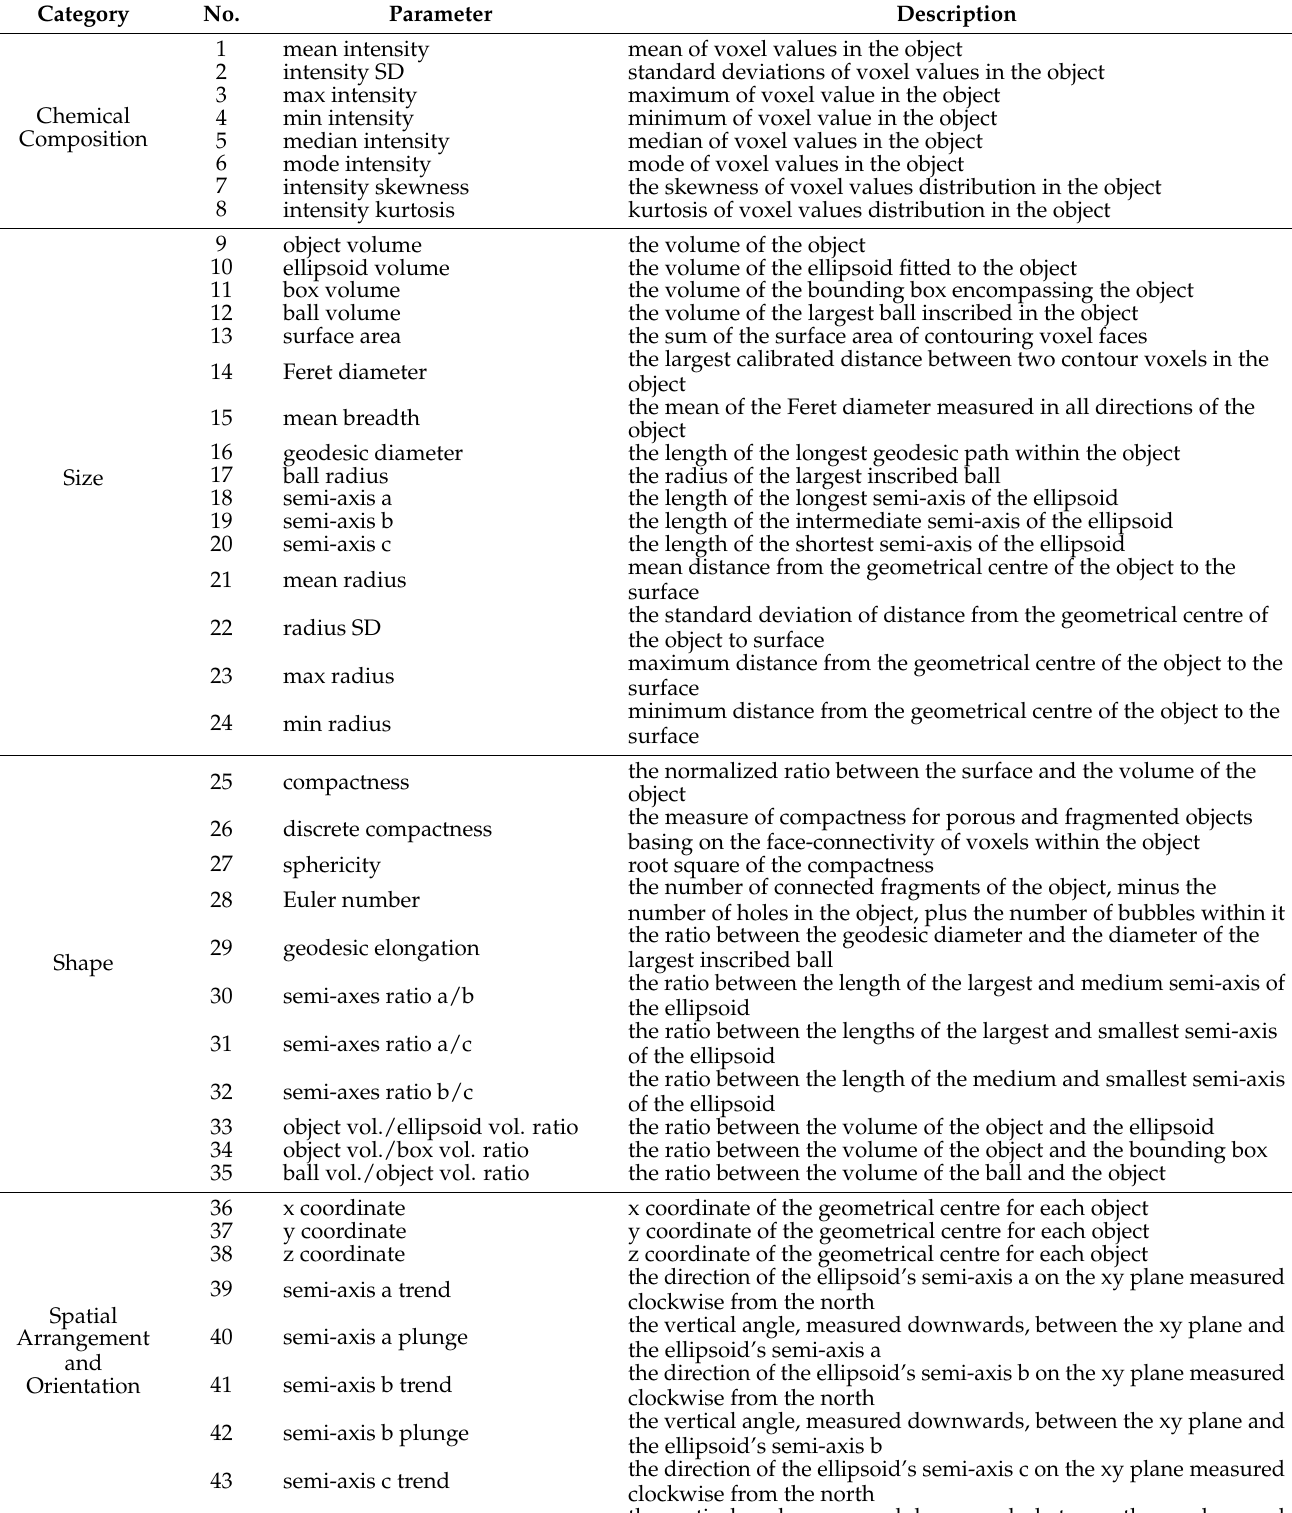
Table A1. The description of the object parameters resulting from the image analysis based on [45,46] and modified by the